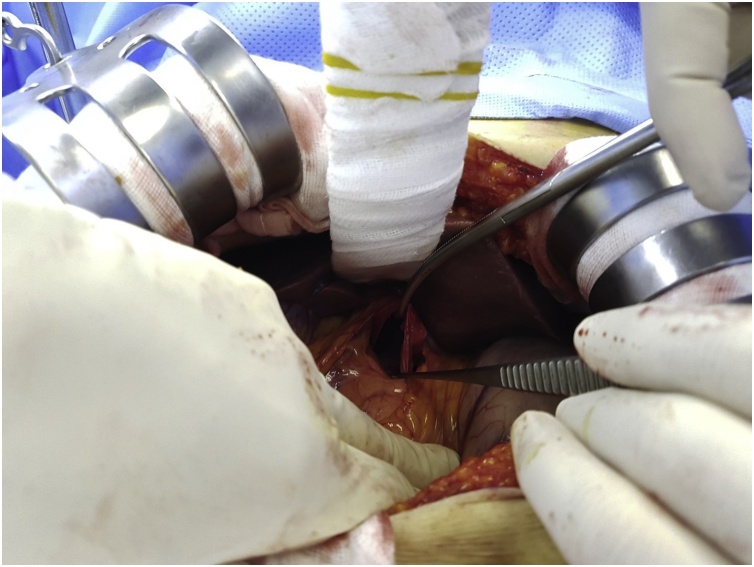
Photograph taken during exploratory laparotomy, showing a ruptured hepatic cyst that had originated from the caudate lobe of the liver.